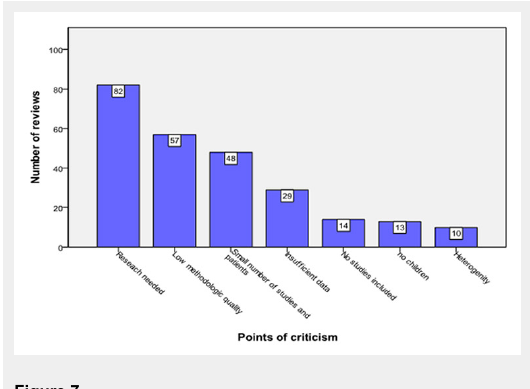
Most common criticisms in Cochrane